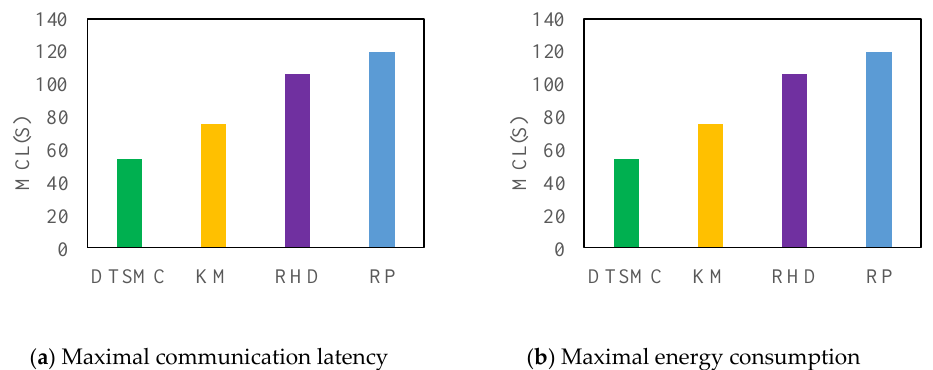
Figure 6. The maximal communication latency (MCL) and maximal energy consumption (MEC) in different methods.